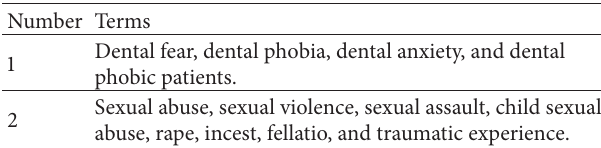
Table 1: Terms used for literature search. Number